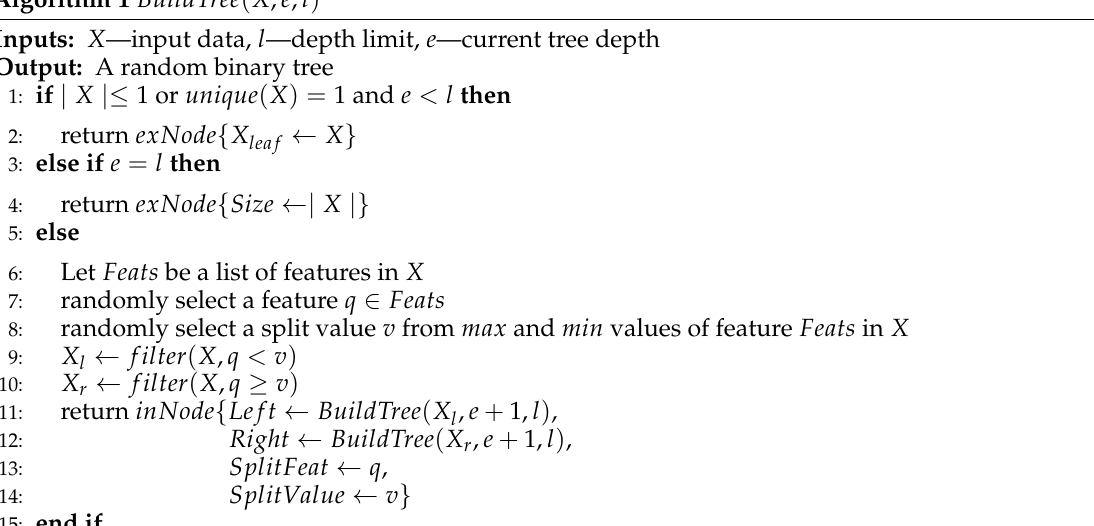
Algorithm 1 BuildTree ( X , e , l